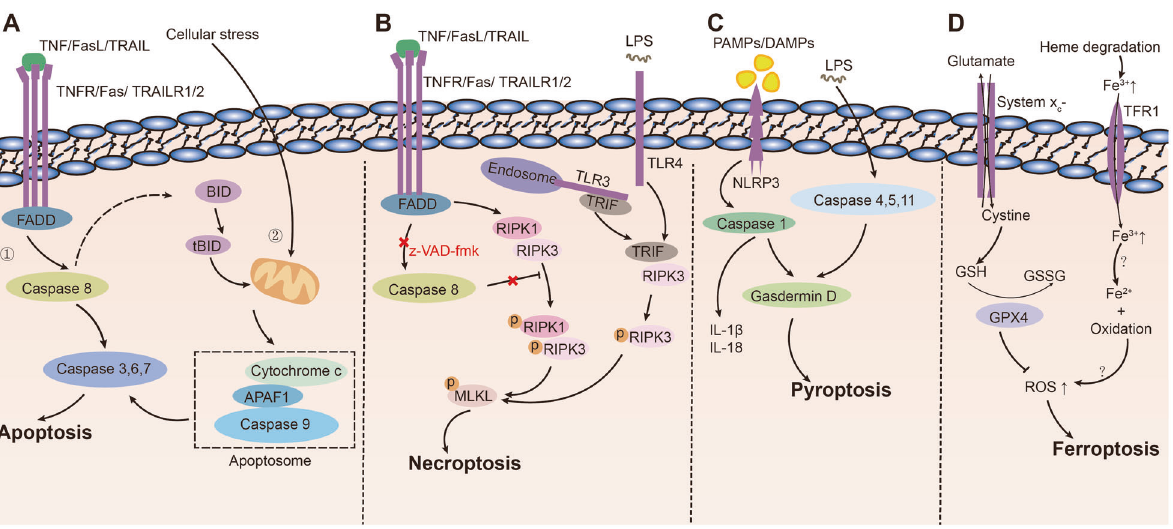
Fig. 2 Molecular mechanisms of four common PCDs. A Molecular mechanisms of apoptosis. B Molecular mechanisms of necroptosis. C Molecular mechanisms of pyroptosis. D Molecular mechanisms of